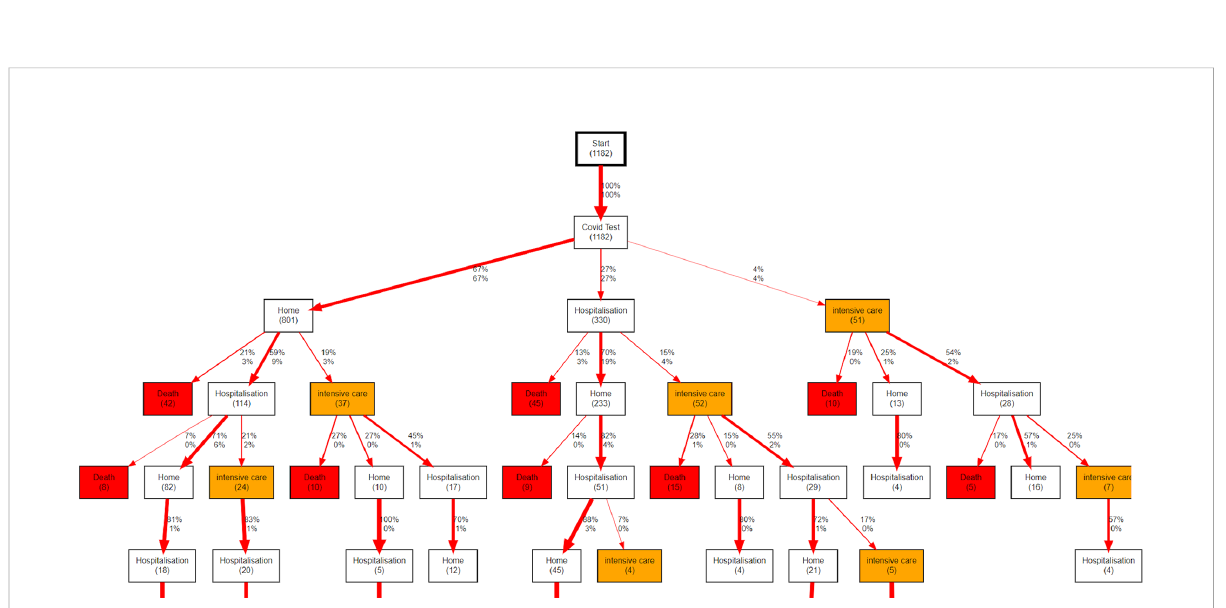
FIGURE 5 Work fl ow describing the evolution of COVID-19 patients with a cancer treated at CHUV after the initial COVID-19 Test . In each node, the number in parentheses shows the absolute count of patients passing through the node. On each edge, the upper percentage shows the the proportion of patients following that edge relative to the total number of patients exiting the node above (not the number of patients entering that node). The lower percentage shows the proportion of patients following that edge relative to the total number of patients in the root